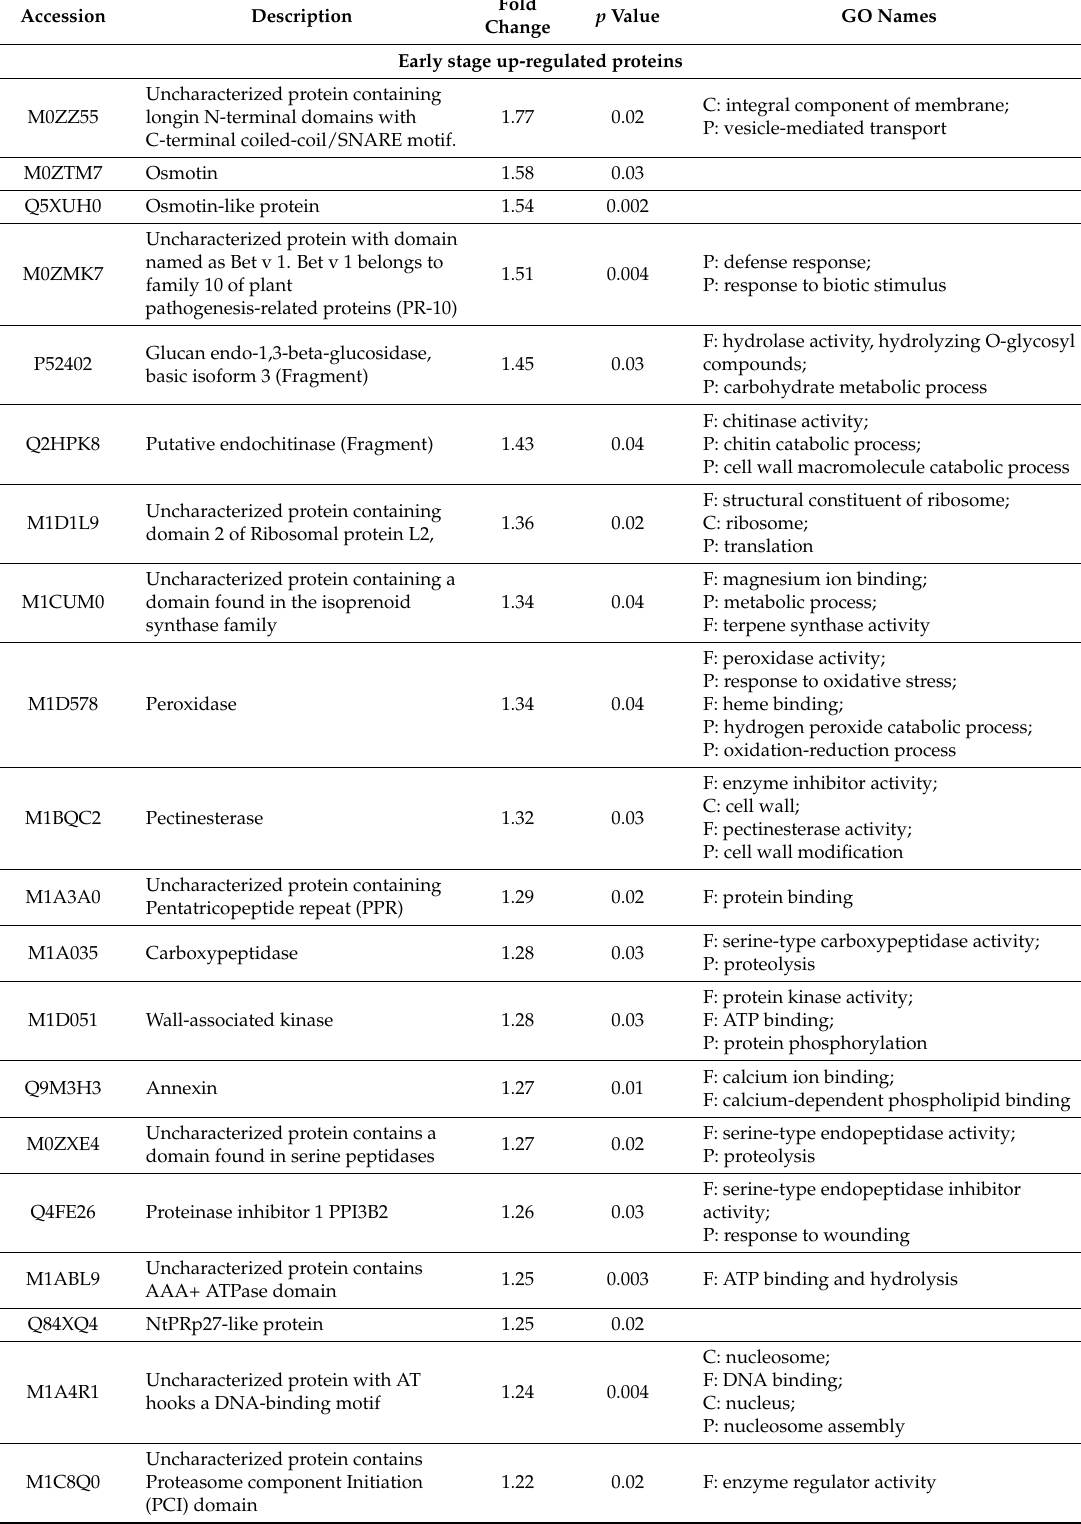
Table 1. Proposed candidate proteins that played an essential role at the early and late disease